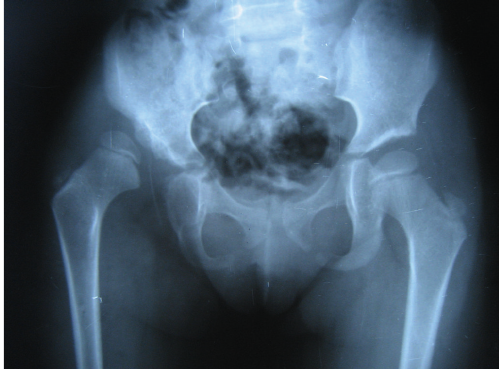
Figure 1: A six-year-old girl with right side neglected modified Severin classification type IV developmental dysplasia of hip.